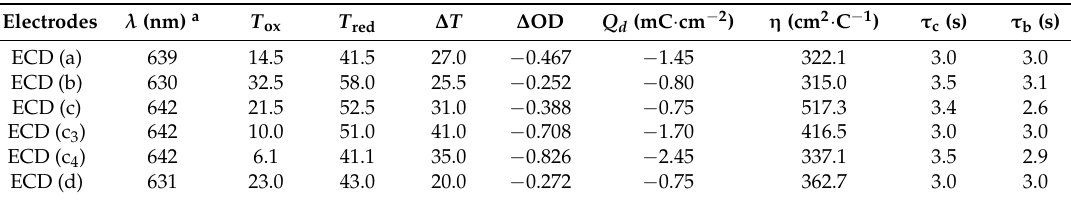
a The selected applied wavelength for the